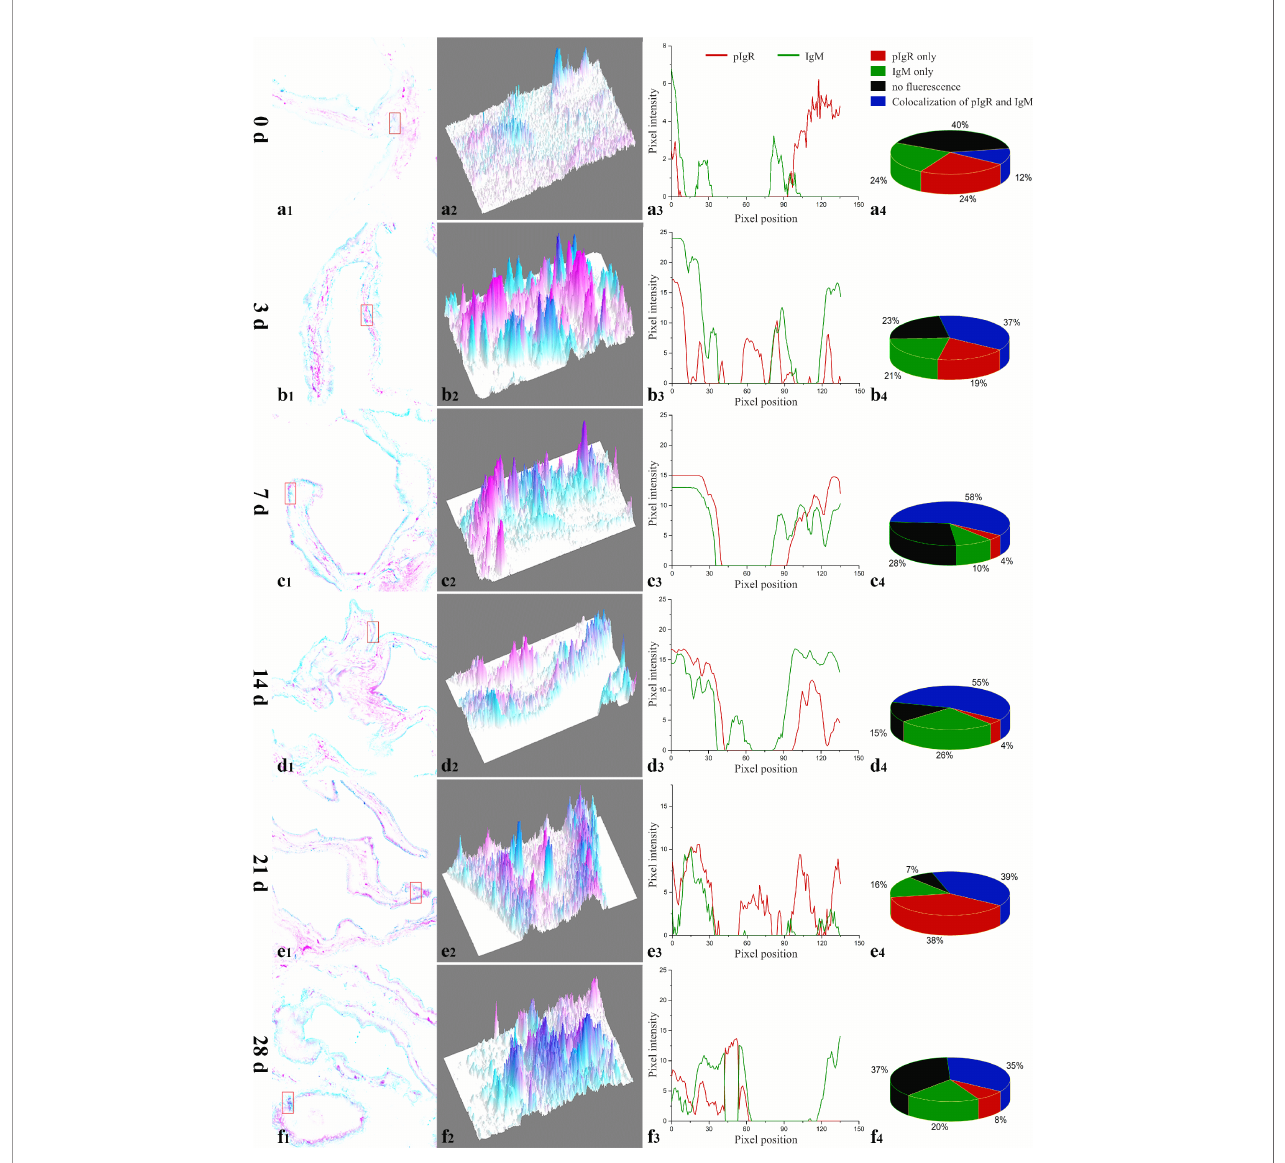
FIGURE 2 | Quantitative image analyses for co-localization of IgM and the fpIgR in a selected area of the intestinal epithelium in Figures 1A – F using ImageJ at different times after immunization. (a1 – f1) A new merged image of Figures 1A – F using green and red to represent the positive signals of the fpIgR and IgM in the intestinal epithelium at 0, 3, 5, 7, 14, 21, and 28 dpi, respectively. (a2 – f2) The interactive 3D surface plots of the selected rectangular area in (a1 – f1) respectively; pixels with positive signals for the two probes were indicated in blue. (a3 – f3) Analyses of co-localization of IgM and the fpIgR according to the absorbance of the two fl uorescence probes in the selected area. (a4 – f4) Pie chart showing the percentage of IgM and fpIgR